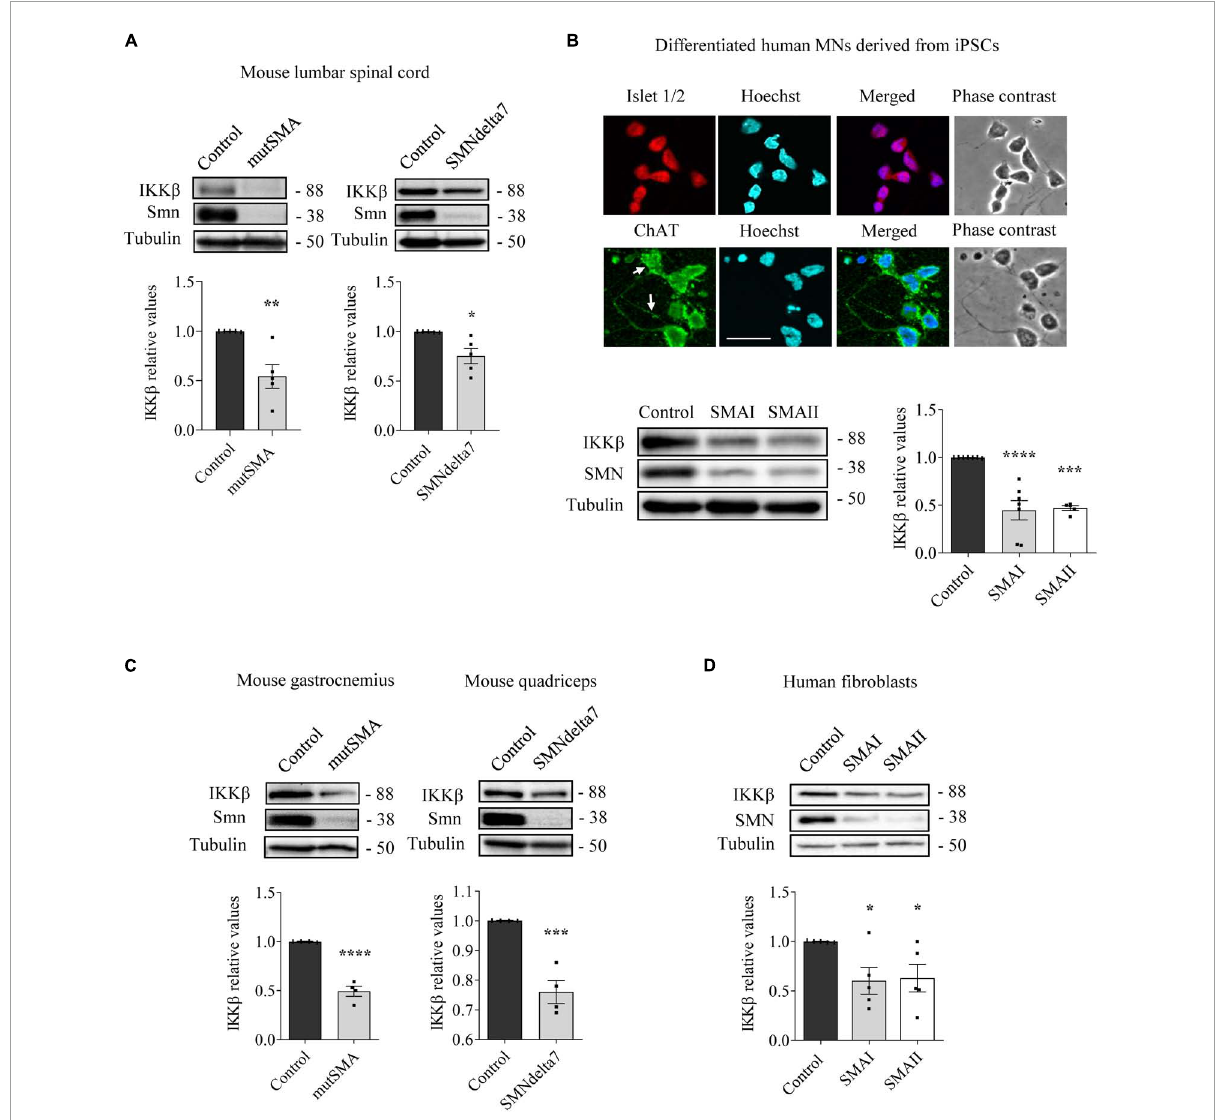
FIGURE1 Reduced levels of inhibitor of kappa B kinase beta (IKK β ) protein in spinal muscular atrophy (SMA) models. (A) Total cell lysates of P2 control and mutSMA (left) or P5 control and SMNdelta7 (right) spinal cords were submitted to western blot analysis using an anti-IKK β antibody. (B) Representative phase contrast and immunofluorescence images of 7 days differentiated human motoneurons (MNs) show the MN markers Islet1/2 (red) and ChAT (green). Hoechst (blue) staining was used to identify MN nuclei. Scale bar 40 µ m. Protein extracts of 7 days differentiated control, SMAI and SMAII human MNs (B) , P2 control and mutSMA gastrocnemius and P5 control and SMNdelta7 (C) , and 48 h cultured control and SMAI and SMAII patient fibroblasts cell lines (D) were submitted to western blot using anti-IKK β and anti-SMN antibodies. Membranes were reprobed using anti- α -tubulin antibody. Graph values represent the expression of IKK β versus α -tubulin and correspond to the quantification of at least four independent experiments ± SEM. Asterisks indicate significant differences using Student t -test (A,C) or one-way Anova with Dunnett’s multiple comparisons post-test (B,D) (* p < 0.05, ** p < 0.01, *** p < 0.001, **** p <